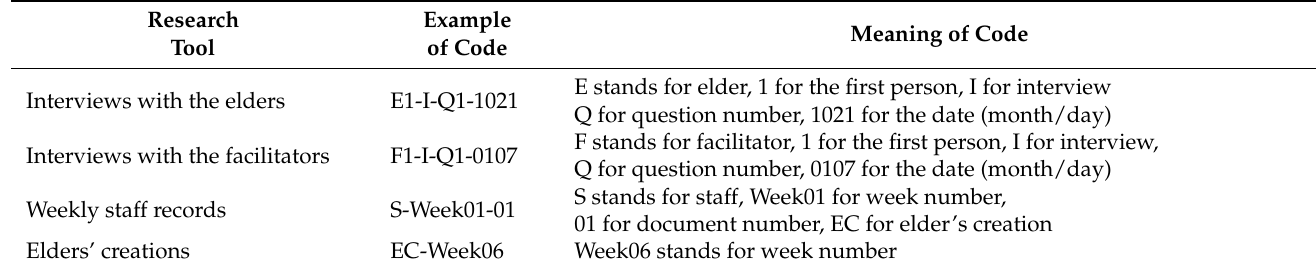
Table 2. Data Coding.